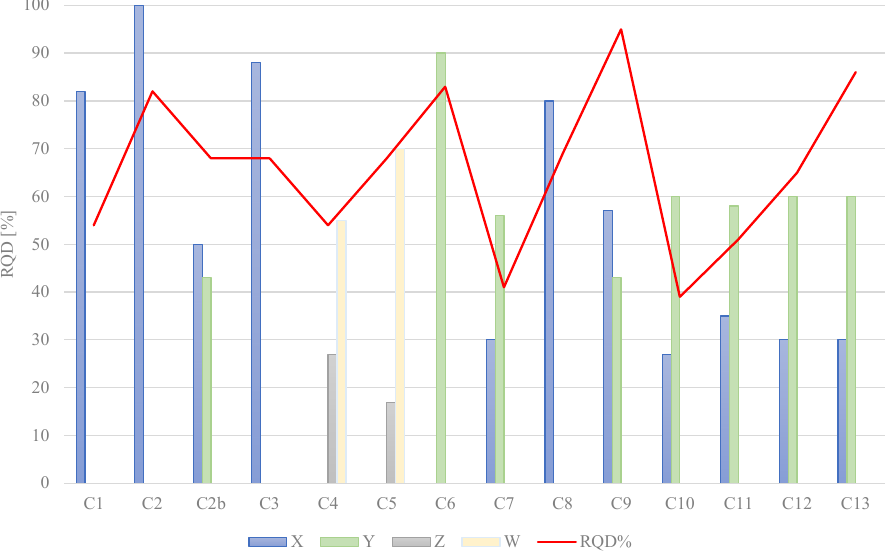
Figure 7. RQD index of core samples, correlated with types of masonry (X, Y, Z, and W).